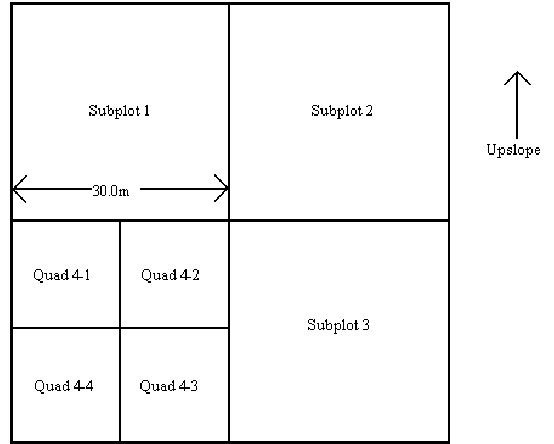
Figure 2. Representative macroplot layout and subplot numbering scheme. The macroplot scale is 60 m by 60 m. The subplots are numbered sequentially in clockwise direction beginning with the upslope-left subplot. The quads are numbered sequentially in a clockwise direction. The layout of subplots 1, 2 and 3 are similar.